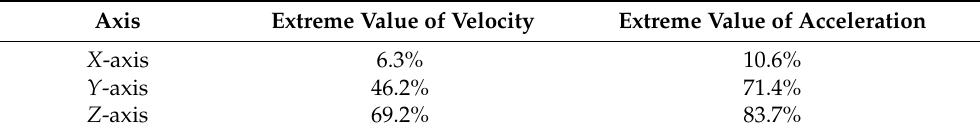
Table 2. Optimization ratios of the proposed method compared with the compared method.